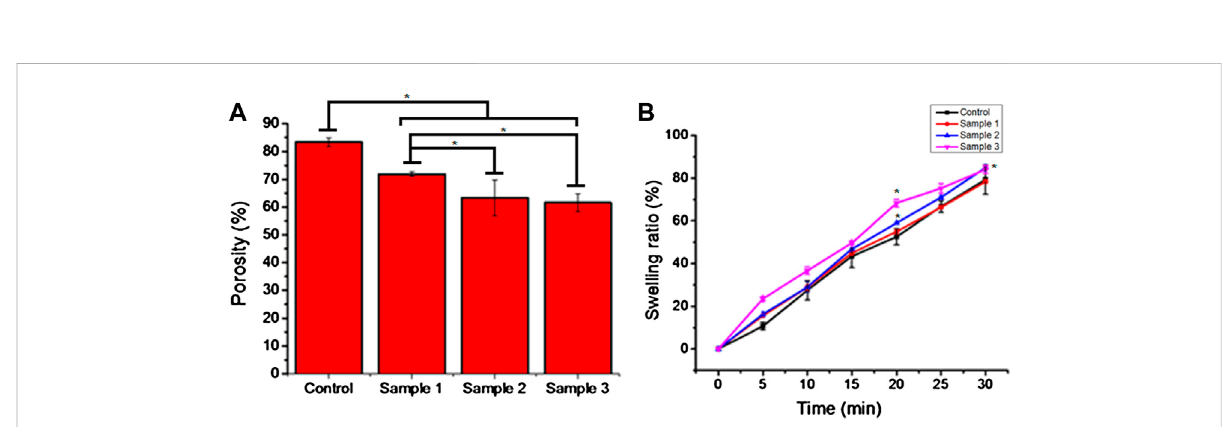
FIGURE 4 Porosity (A) and swelling ratio (B) ofthe bio-polymericbeads in1X PBS solution indicate the hydrophobicityand voids in thecontrol and ESMP- modi fi ed beads (samples 1, 2, and 3). Here, * indicates the signi fi cant difference between samples ( p <